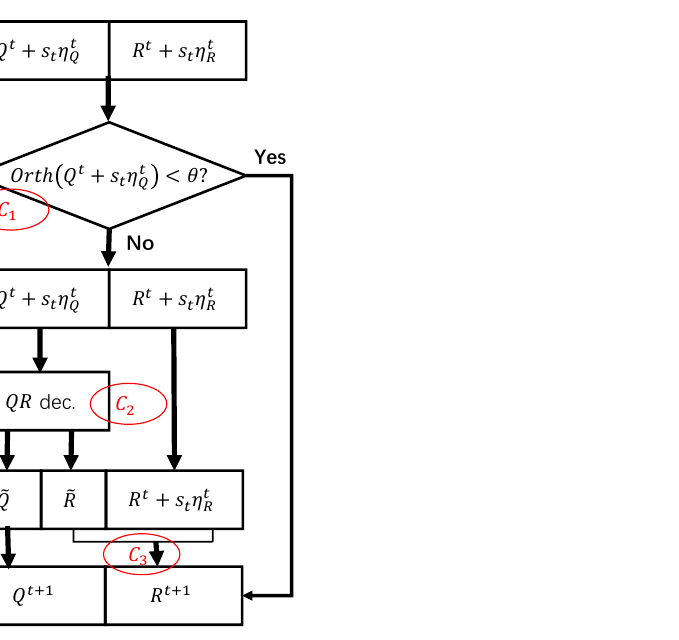
Figure 2. Illustration of the QR factorization in retraction.